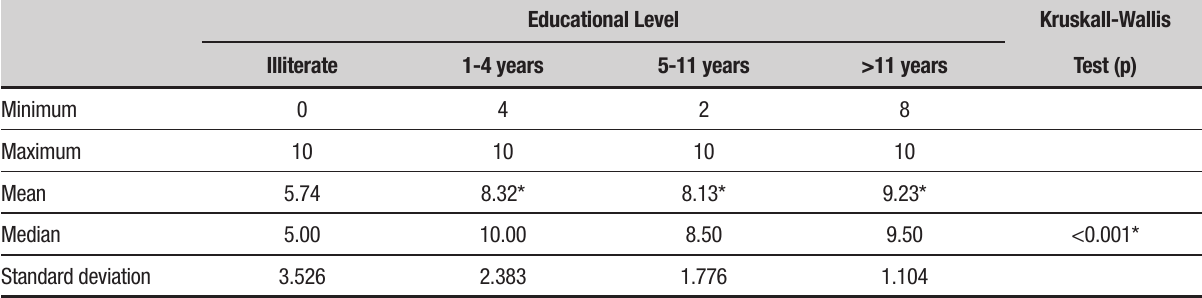
Table 1. Means and standard deviations on CDT according to educational